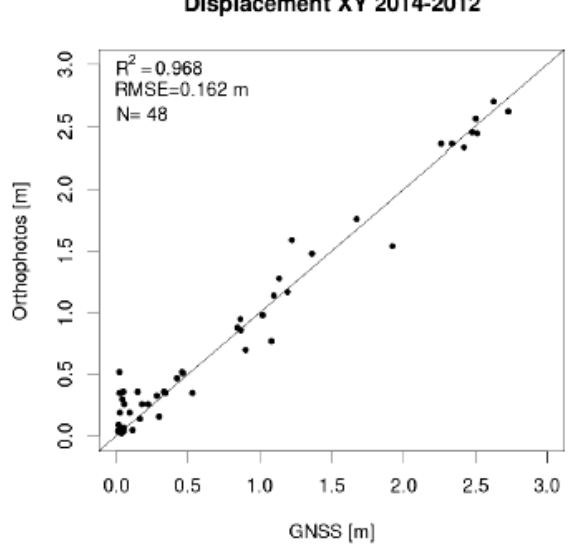
Figure 5: Scatterplot between displacements obtained from the comparison of UAS orthophotos manual analysis and GNSS measurements on 48 points.